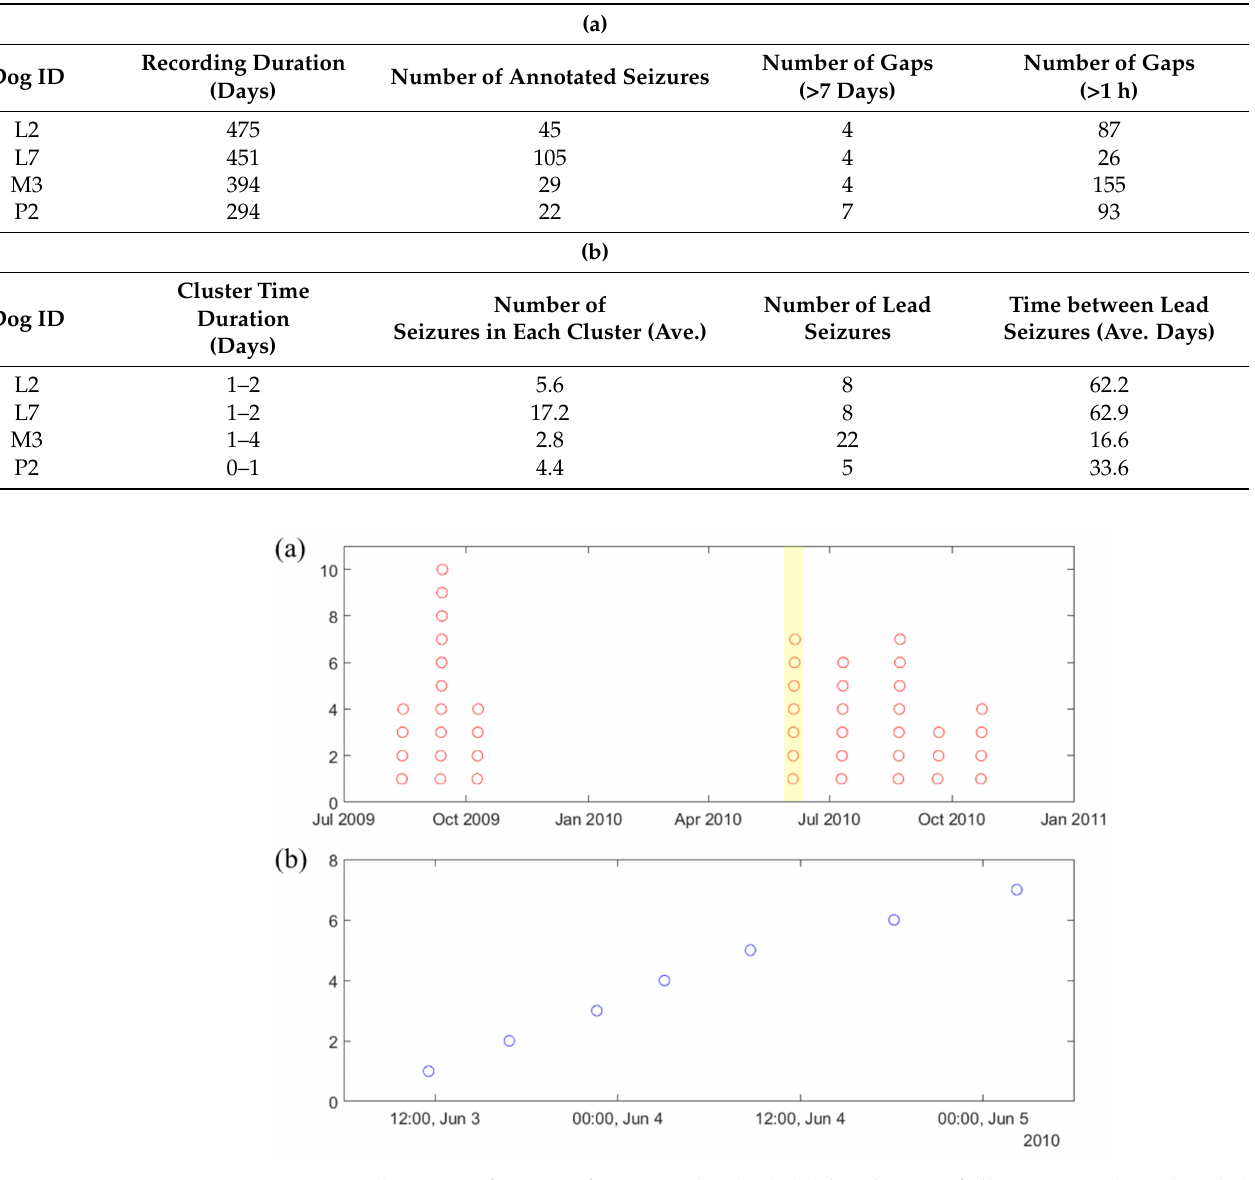
Figure 2. Clustering of seizures for canine data (L2): ( a ) distribution of all 45 seizures (in red circles) during the whole period (July 2009–November 2010), indicating strong clustering. ( b ) distribution of 7 seizures (in blue circles) within one cluster highlighted in ( a ), during time period 3–5 June 2010. Statistical summary of seizure clusters (for all four dogs) is shown in Table 1b.